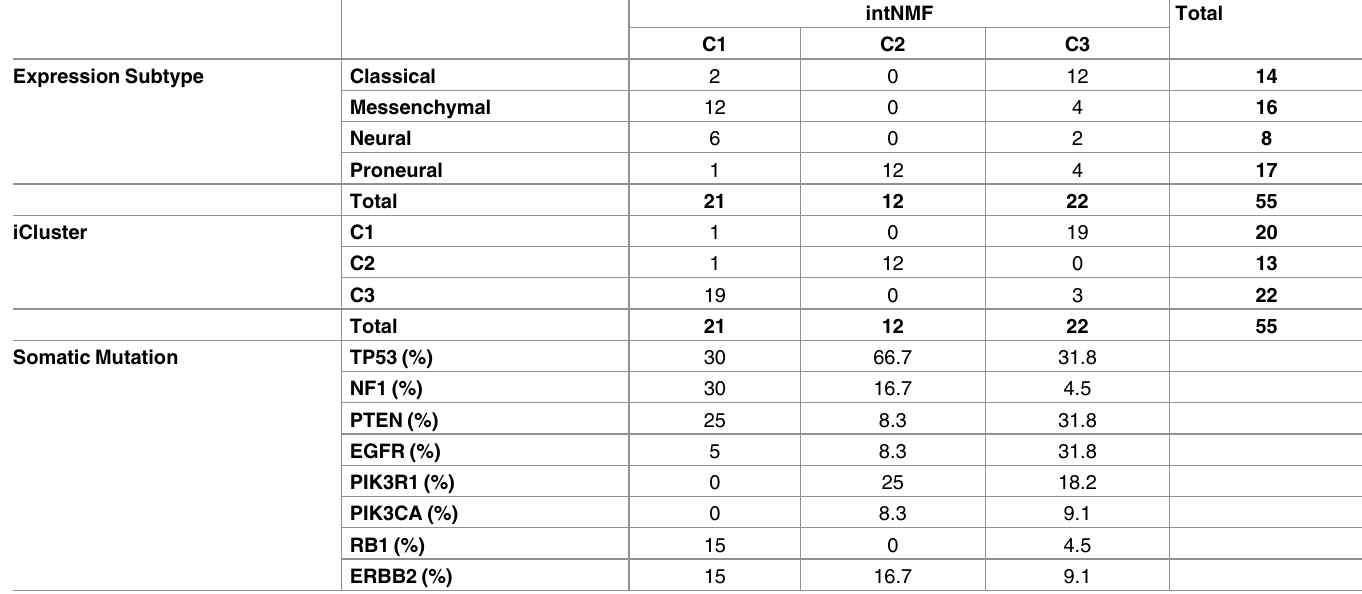
Table 2. Cross tabulation of intNMF cluster subtypes with (i) Expression cluster subtypes [44] and (ii) iCluster subtypes [37] using Glioblastoma data. The summary table, followedby cross tabulation, representssomatic mutations in a few genes (highlighted by previousstudies [44, 45]) presentedas percentage of their presence in each of the three integrative clusters. Graphicalrepresentation of this table has been providedwith S8